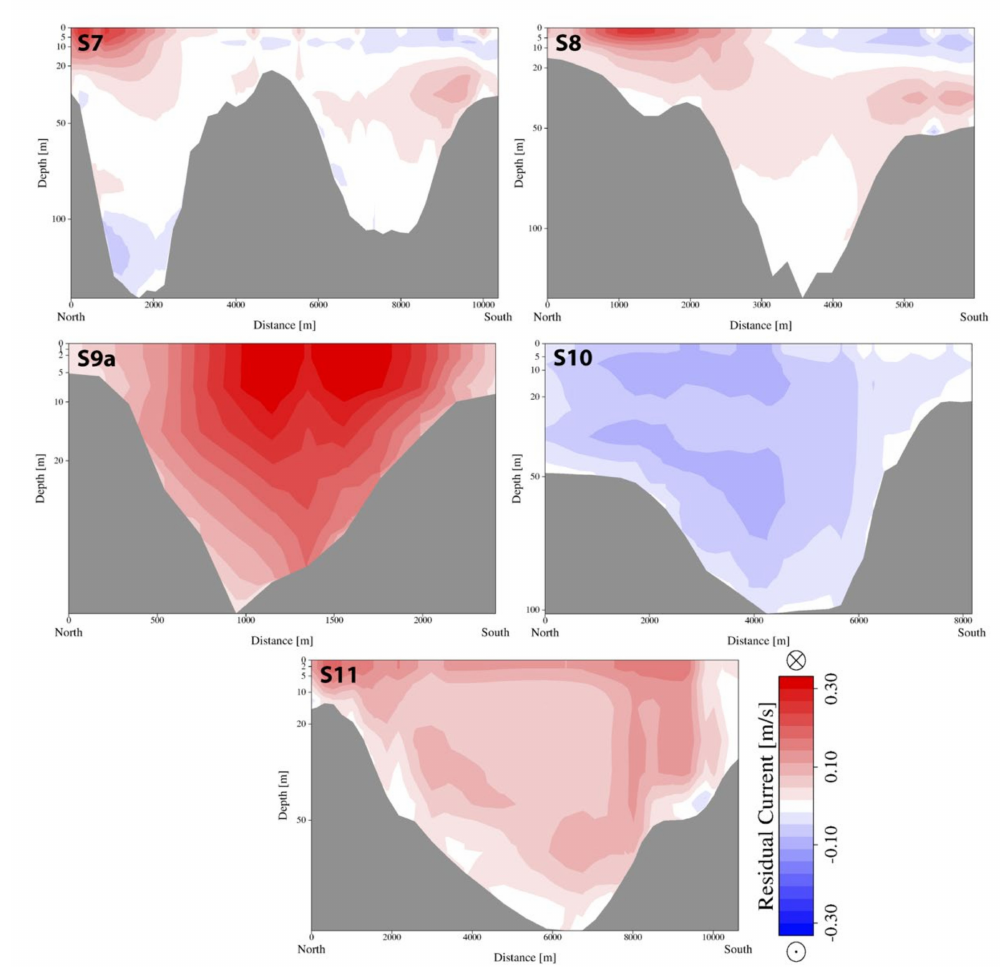
Figure A3. Yearly residual flow intensity through the sections S7–S11 along the BC as reported in Figure 2. Positive values indicate an eastward